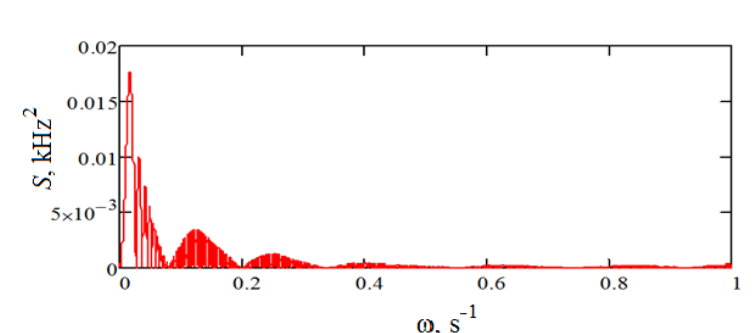
Figure 9. Power spectral density.